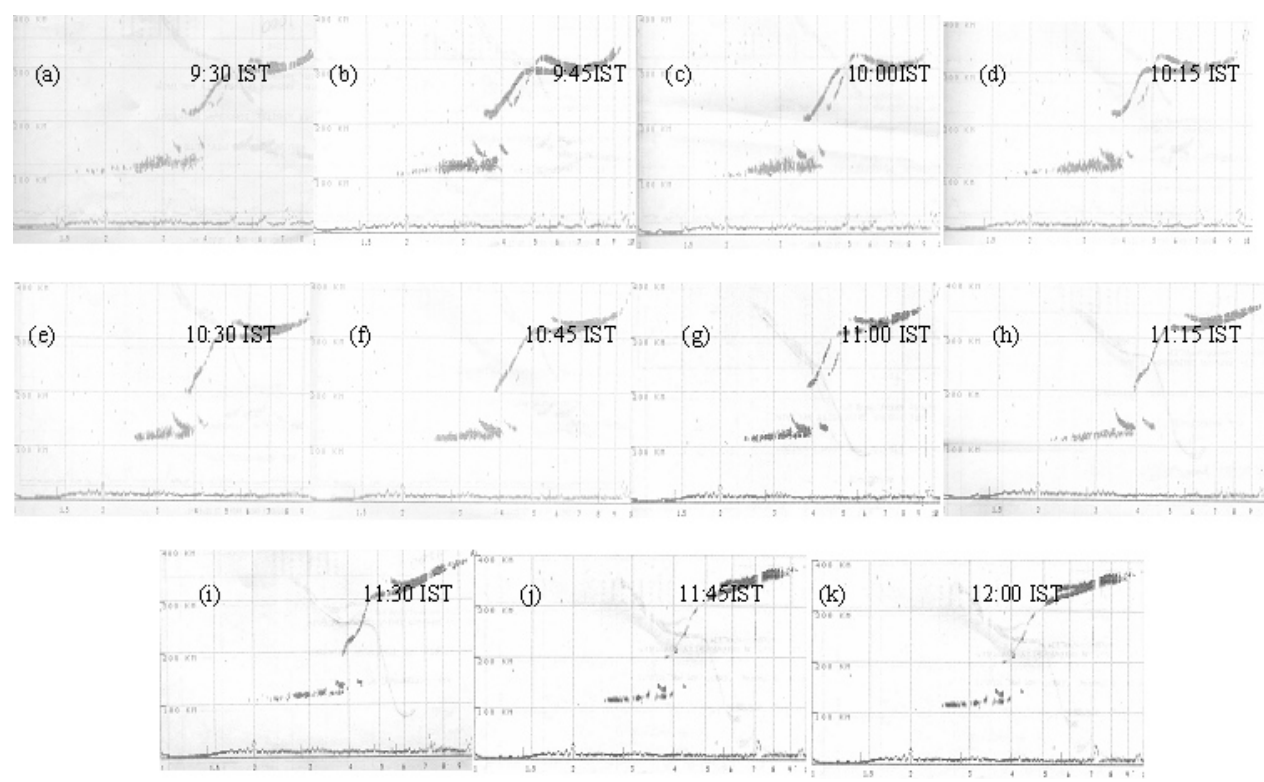
Fig. 1a. Sample Ionograms showing the daytime descending intermediate layers at Waltair during 09:30 to 12:00IST on 30 January